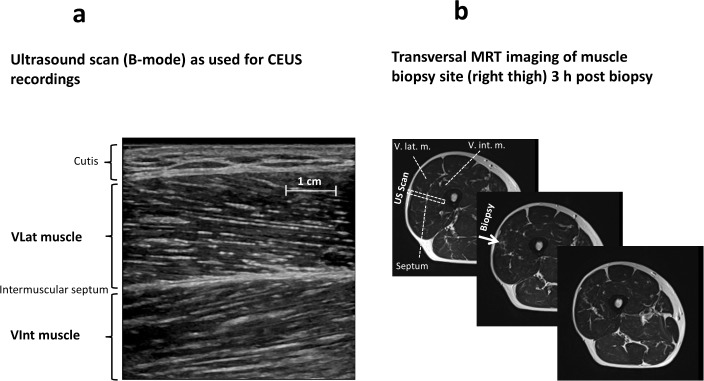
‘Ultrasound and MRT imaging of CEUS and Biopsy muscle site’.Fig 2 a) US B-mode image of a typical combined vastus lateralis (VLat) and intermedius (VInt) CEUS scan with the scanner position chosen parallel to the VLat muscle fiber orientation (i.e. from proximal/lateral to distal/medial). The intramuscular septum separating both muscles is indicated, the mean depth was similar between middle aged (MA) and young (YG) subjects and not significantly different between the conditions before, during, and post-exercise (see also the ‘Methods‘ section on Contrast-enhances US (CEUS). d) Thigh MRT-imaging transversal section at the exact site of VLat muscle biopsy (middle) and CEUS recording as well as 1 cm proximal (left) and distal (right). Note that this MRT was obtained 3 h after a muscle biopsy to visualize the exact biopsy site (local fluid /blood accumulation) indicated by the arrow.